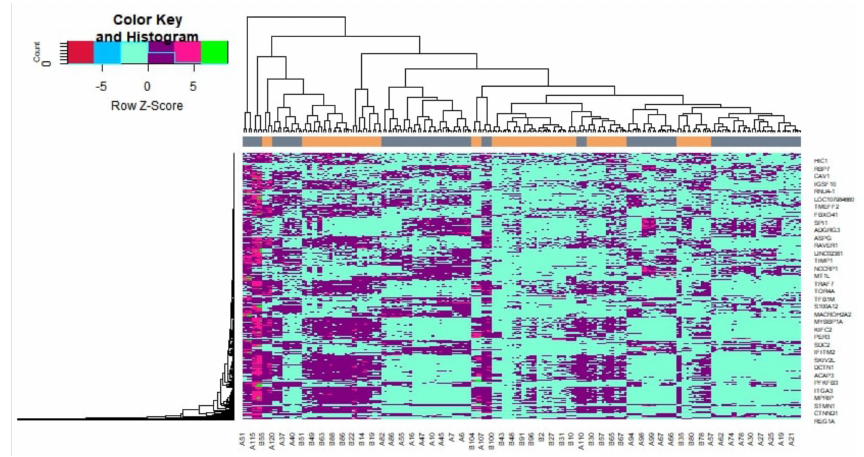
Figure 3. Heat map of differentially expressed genes. Legend on the top left indicate log fold change ingenes. (A1–A120 = non-diabetic obese samples; B1–B104 = diabetic obese